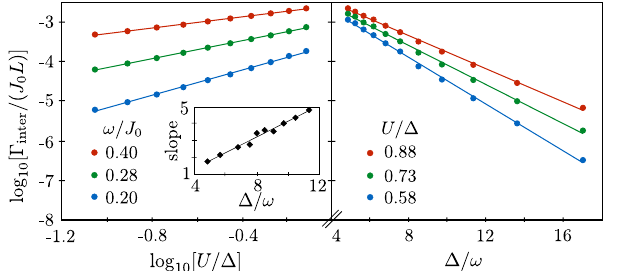
FIG. 5. Interband excitation rate Γ obtained from exact inter numerical evolution of a system with eight fermions on 32 sites ( L ¼ 16 unit cells). Left panel: Log-log plot showing dependence = ð J 0 L Þ on interaction strength U , for three fixed values of of Γ inter frequency ω and for the band-structure parameter λ ¼ 0 . 56 . Trend lines are linear fits to the data, confirming a power-law depend- ence consistent with Eq. (11). Inset: Power-law exponent as a function of ω , extracted from linear fits to the data. Right panel: Log-linear plot showing the driving-frequency dependence of Γ = ð J 0 L Þ , indicating an exponential dependence on 1 = ω , for inter the same model